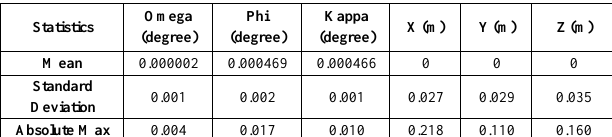
Figure 2. Relative error distributions of the exterior orientations estimated from the enhanced images After normal distribution fitting, the mean and standard deviation of the errors of each exterior orientation is obtained. Table 1 lists statistics of these errors. It can be seen that the means of the errors of the three linear orientations are zero, and that of the angular orientations are almost zero. The standard deviations of the errors of the angular orientations are at the level of 0.001 degrees, and that of the linear orientations are at the level of centimeters. The maximal absolute errors of the angular orientations are at the level of 0.01 degrees, and that of the linear orientations are at the level of decimeters. The statistics of the relative errors indicate that the image orientation accuracy of the original images and the enhanced images are comparable. Table 1. Statistics of the errors of the exterior orientations estimated from the enhanced